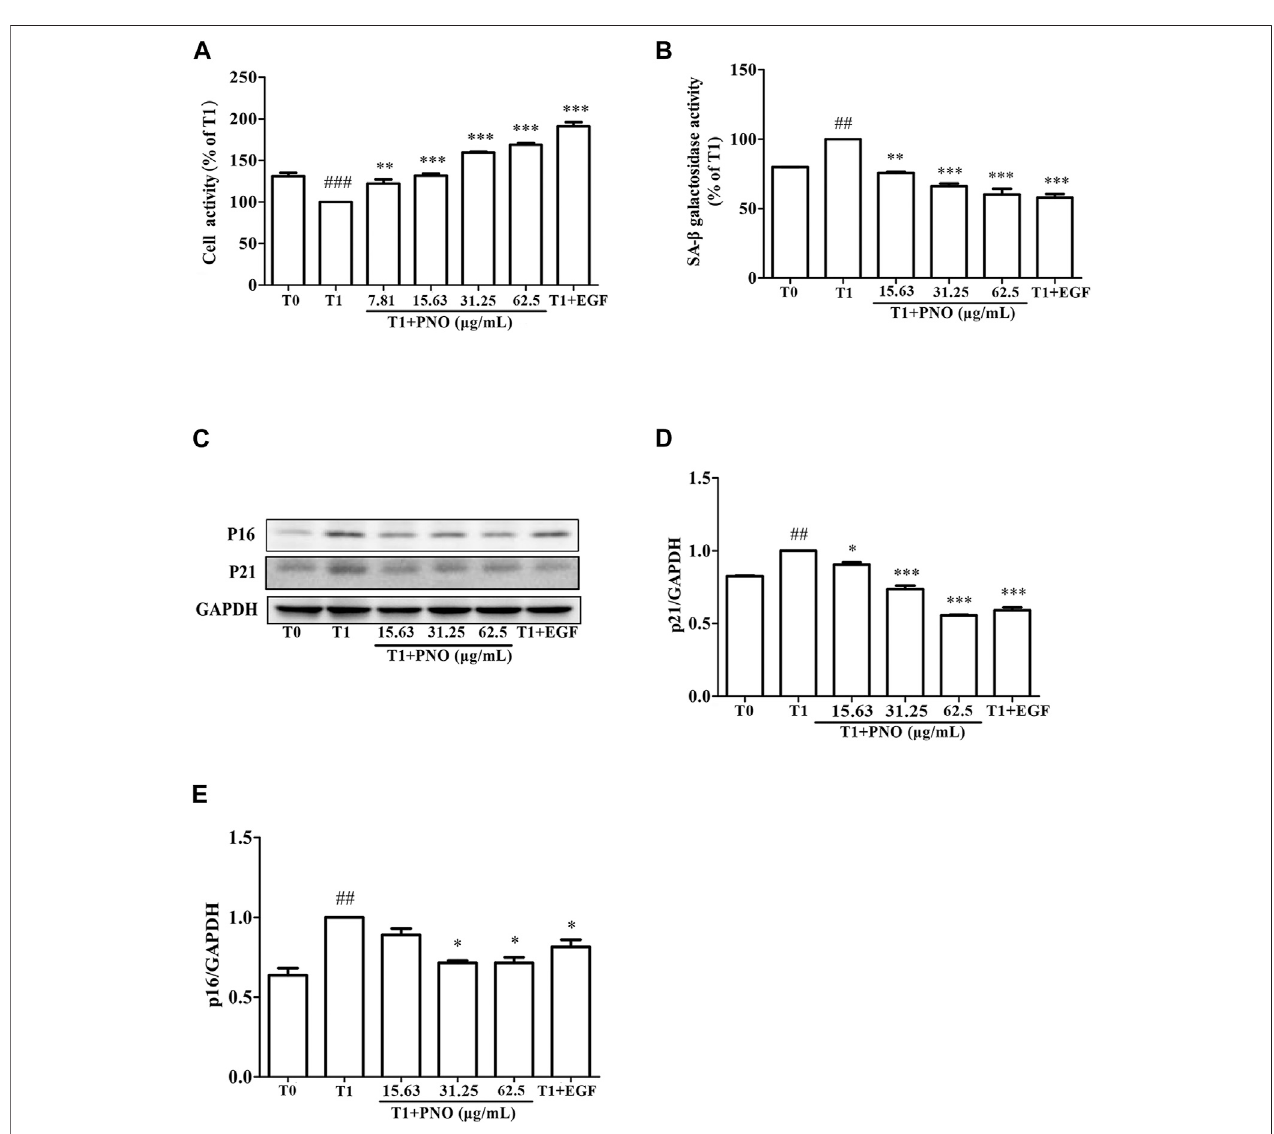
FIGURE 3 | Effect of PNO on cell viability and replicative senescence of NIH-3T3 cells. (A) Effect of PNO on cell viability of replicative senescent NIH-3T3 cells. (B) EffectofPNOonSA- β -GalactivityofreplicativesenescentNIH-3T3cells. (C – E) EffectofPNOonexpressionofp16,p21proteinsbyreplicativesenescentNIH-3T3cells as detected by western blotting (WB). Quanti fi cation of bands relative to GAPDH using Image J software. All data are presented as the mean ± SD of at least three independent experiments. # indicates a signi fi cant different relative to the T0 group. ## p < 0.01, ### p < 0.001. *Indicates a signi fi cant different relative to the T1 group. * p < 0.05, ** p < 0.01, *** p <